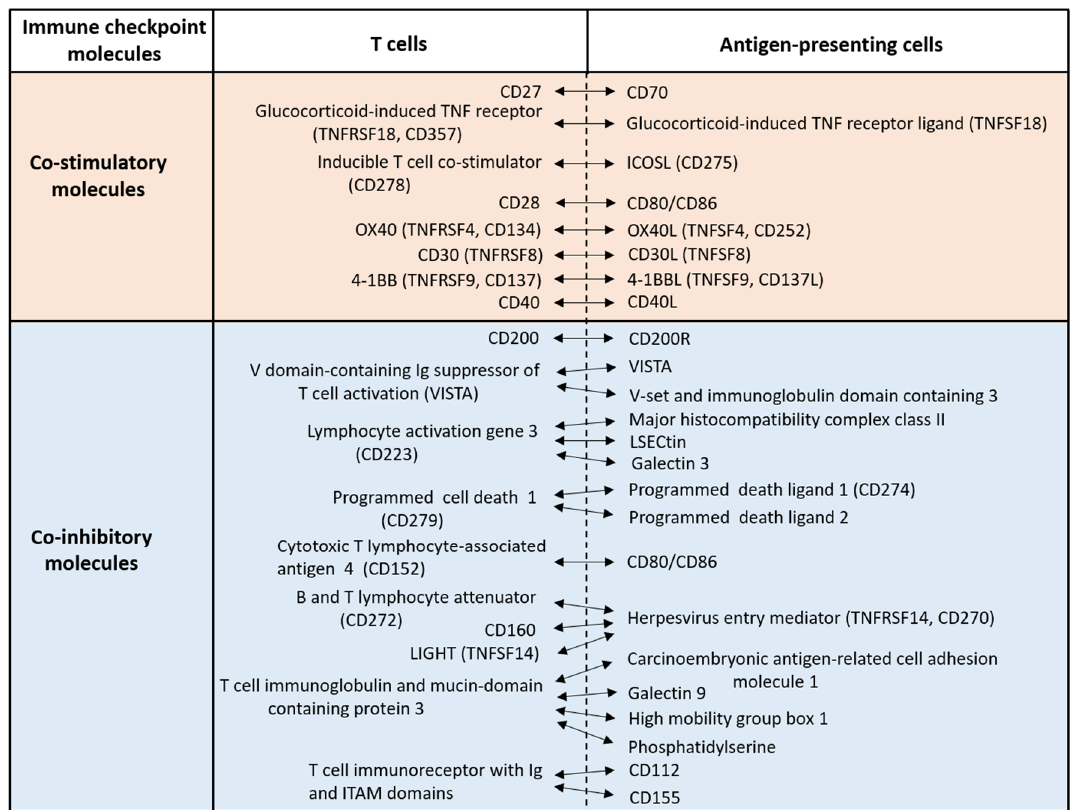
Figure 1. Representative immune checkpoint molecules. T cells express a variety of co-stimulatory and co-inhibitory molecules which are activated by specific molecules on antigen-presenting cells. These co-stimulatory and co-inhibitory molecules are recently called immune checkpoint molecules.